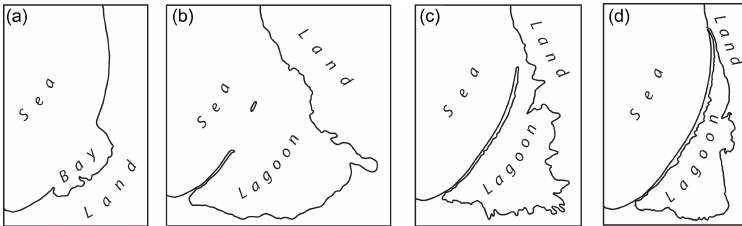
Figure 2. Curonian Spit evolution phases: (a) beginning of the third stage of Littorina Sea transgression (4kyr BC), (b) end of Littorina Sea transgression (3kyr BC), (c) Mya Sea transgression (2kyr BC), and (d) contemporary Baltic Sea and Curonian Lagoon (Karte des